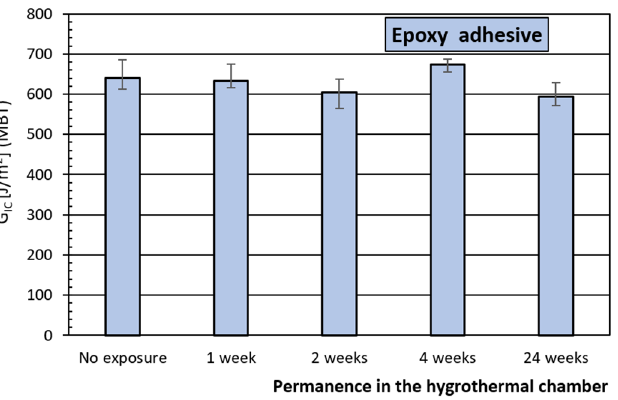
Figure 5. Evolution of the energy release rate under mode I of the adhesive with an epoxy base, hygrothermal loading.